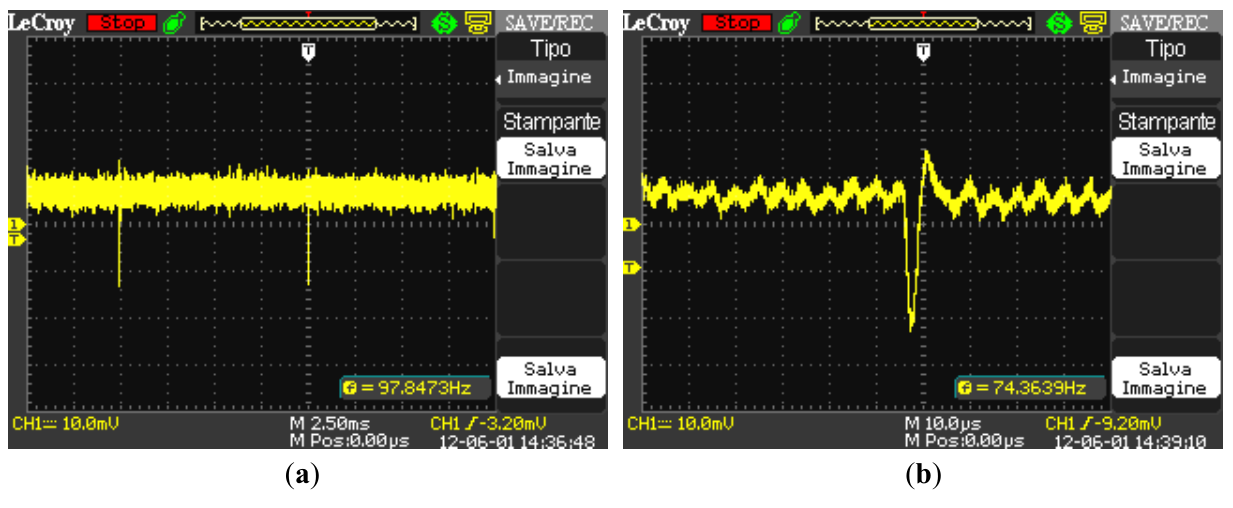
Figure 17. ( a ) Positive pole to ground voltage; ( b ) Particular of the DC voltage